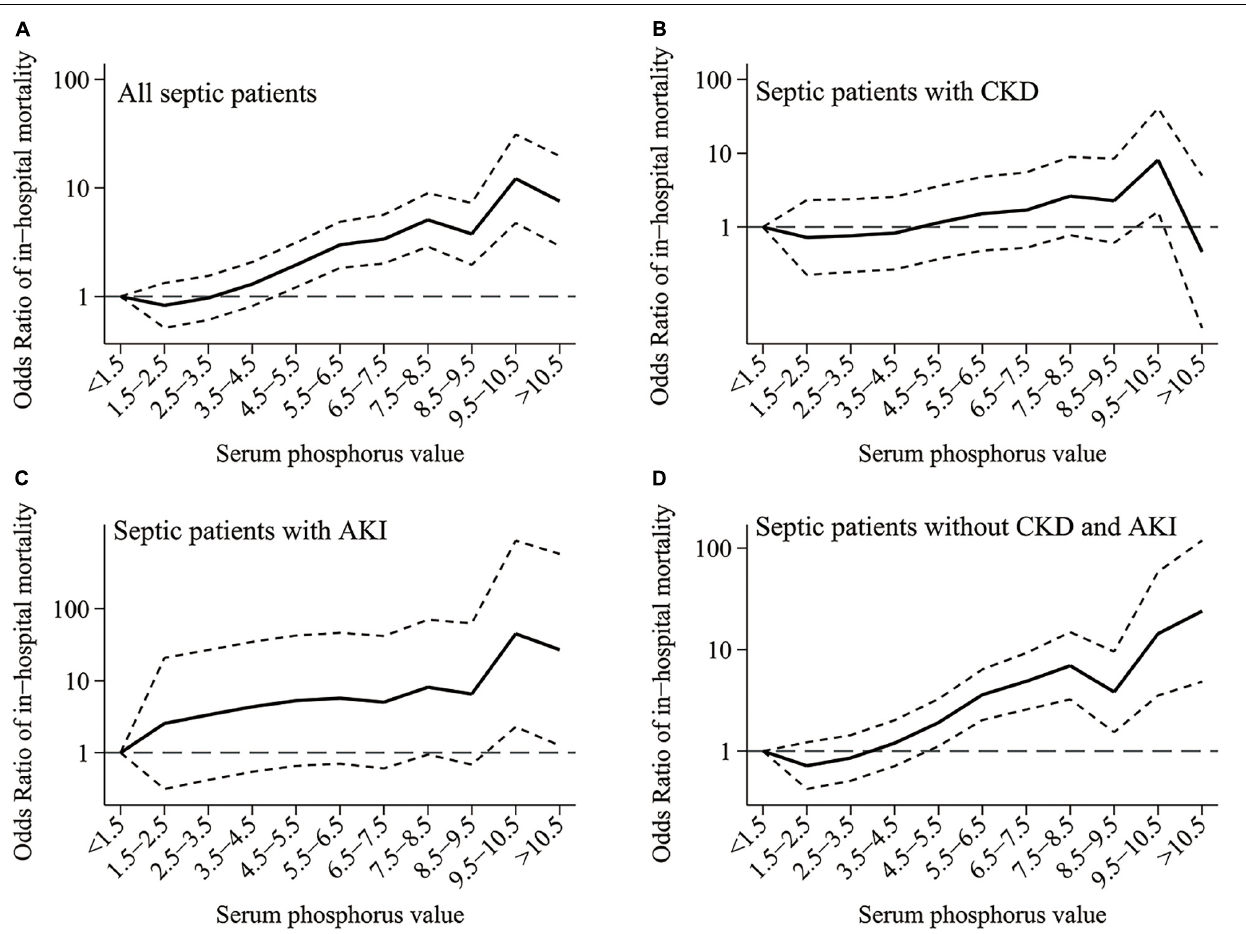
FIGURE 3 | (A–D) Unadjusted odds ratios (Ors) of in-hospital mortality with < 1.5 mg/dl as the reference group in patients with sepsis with CKD and AKI or not. The figure shows higher Pi was related to a higher risk of in-hospital mortality even in the normal range though it was only significant for extremely high value in the CKD and AKI subgroups. CKD, chronic kidney disease; AKI, acute kidney